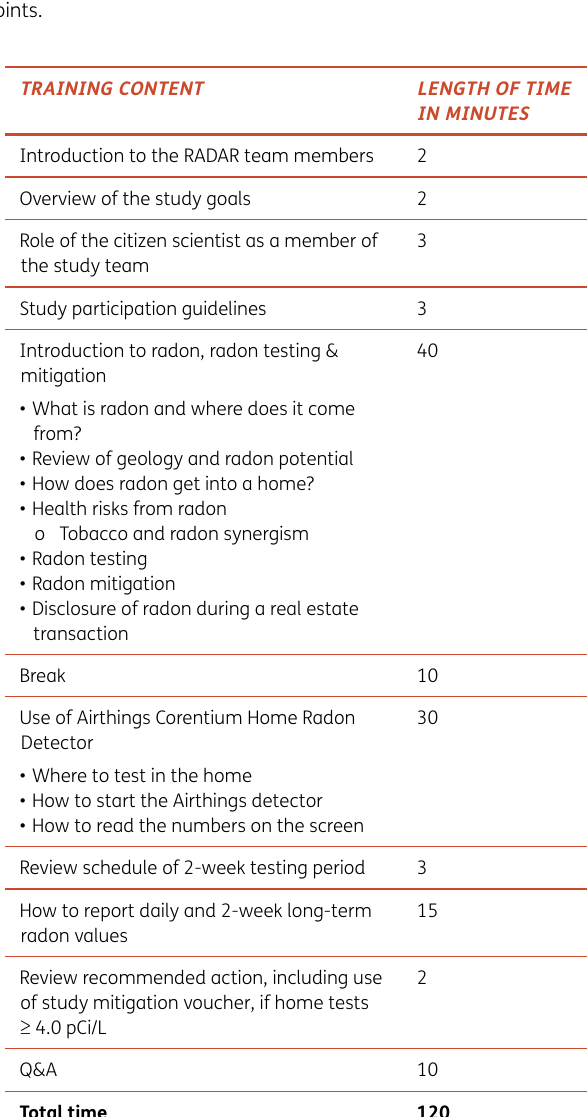
Figure 2 Data collection, training, radon testing, and report back time points.